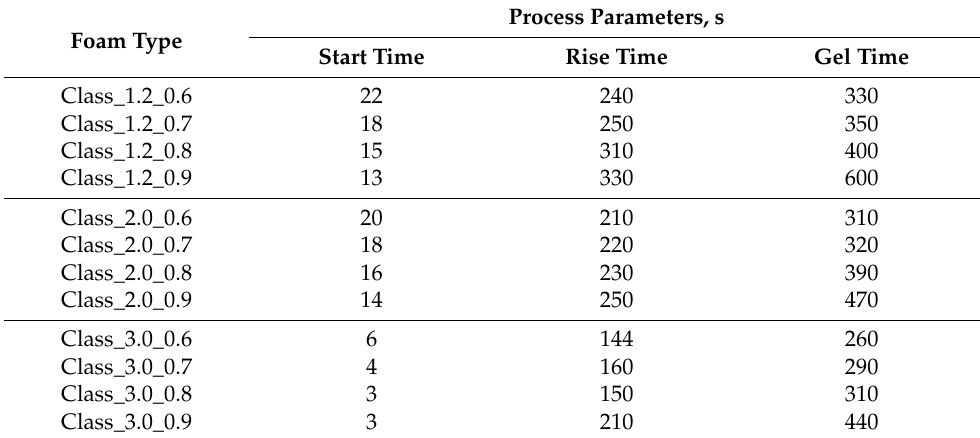
Table 2. Process times for different values of the isocyanate index and water content.